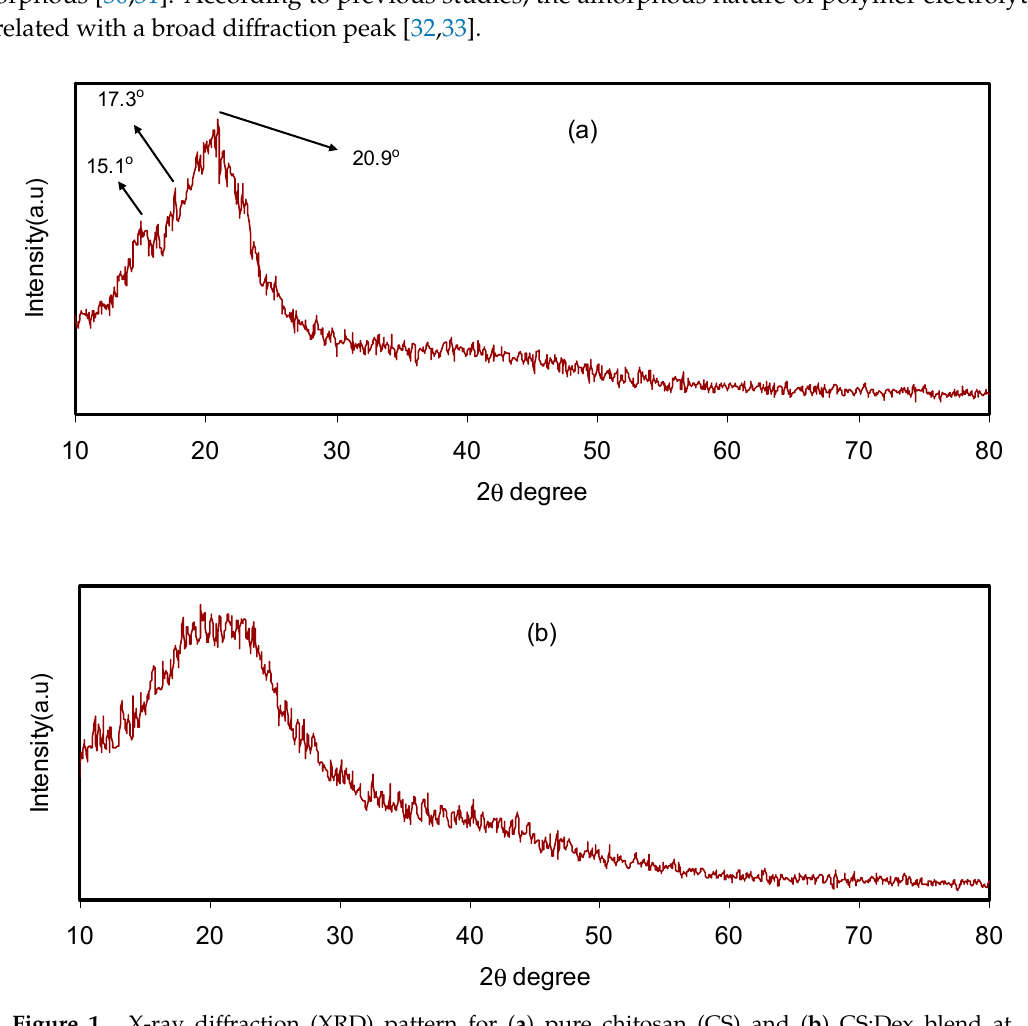
Figure 1. X-ray di ff raction (XRD) pattern for ( a ) pure chitosan (CS) and ( b ) CS:Dex blend at ambient